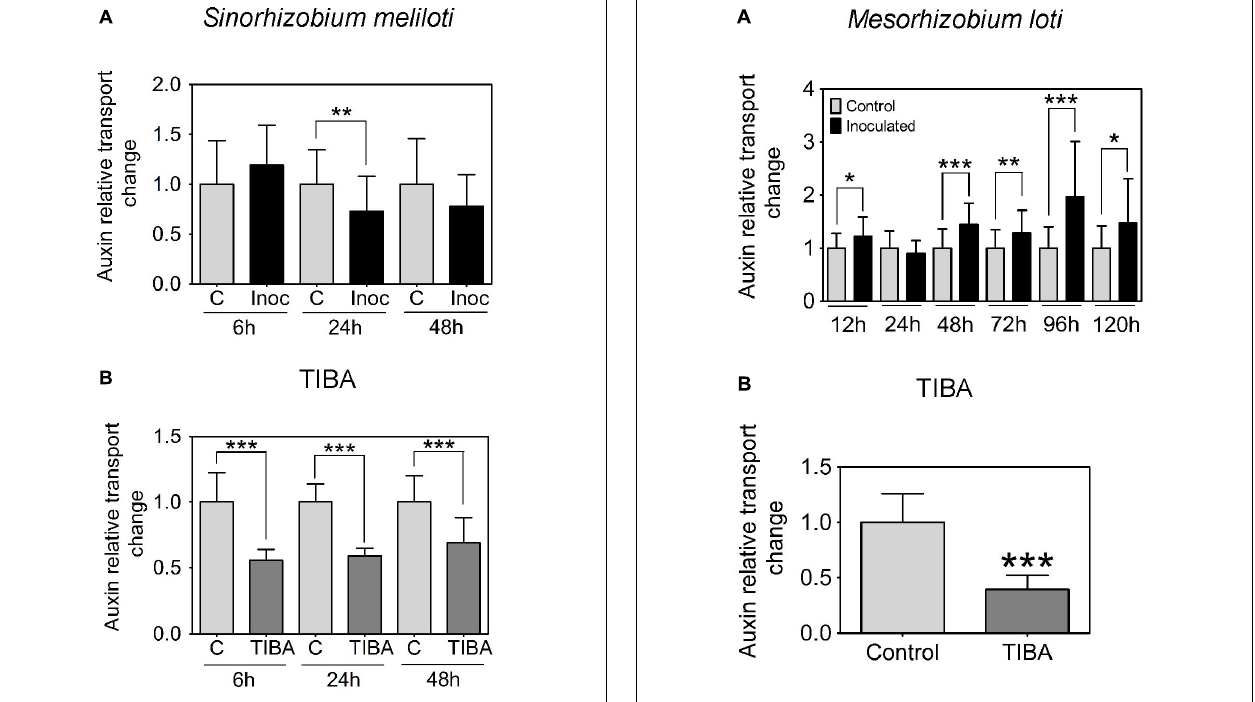
FIGURE 3 | Acropetal auxin transport measurements of L. japonicus root segments. (A) Relative auxin transport changes were measured in mock or Mesorhizobium loti -spot inoculated root segments at 12, 24, 48, 72, 96, and 120 h.p.i. (B) Relative auxin transport changes were measured in mock- or TIBA-treated root segments at 48 h post-treatment. Unpaired t -tests were used for statistical analyses ( p < 0.05, n = 25–30 per treatment or time point). Asterisks indicate significant change in relative auxin transport ( ∗ , significant; ∗∗ , very significant; ∗∗∗ extremely very significant). Graphs show mean and SD. Abbreviation: TIBA, 2,3,5-triiodobenzoic